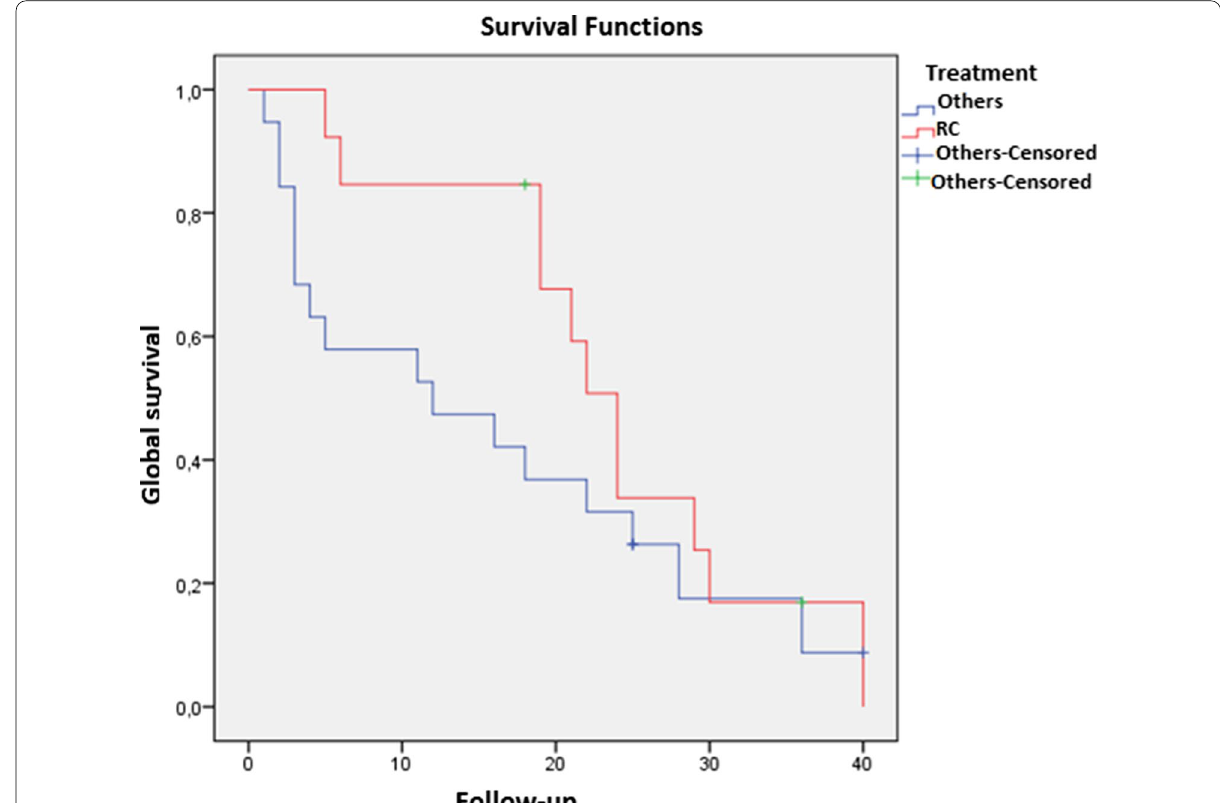
Fig. 1 Represents the overall survival rate in the two groups as a function of time (months) according to